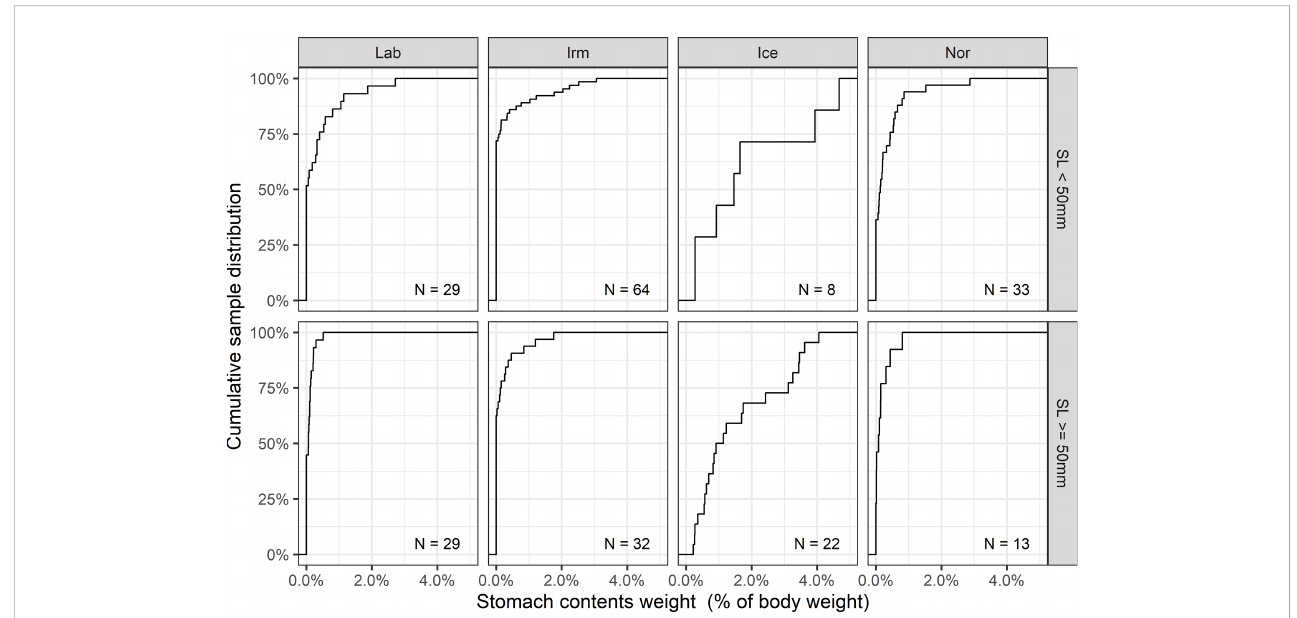
FIGURE 7 Cumulative distribution of prey weight in the stomachs relative to body weight. Numbers denote sampled individuals in each group.